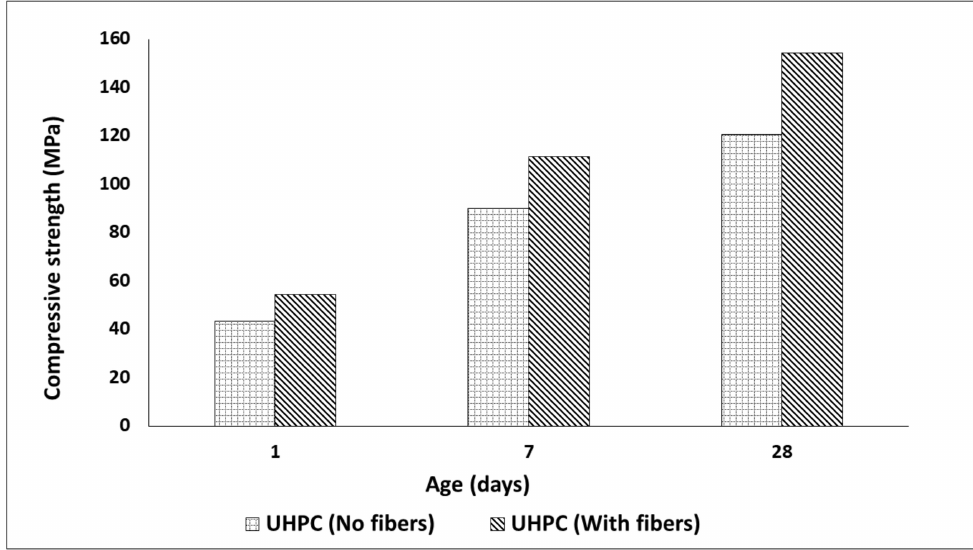
Figure 6. Preliminary UHPC compressive strength development without and with